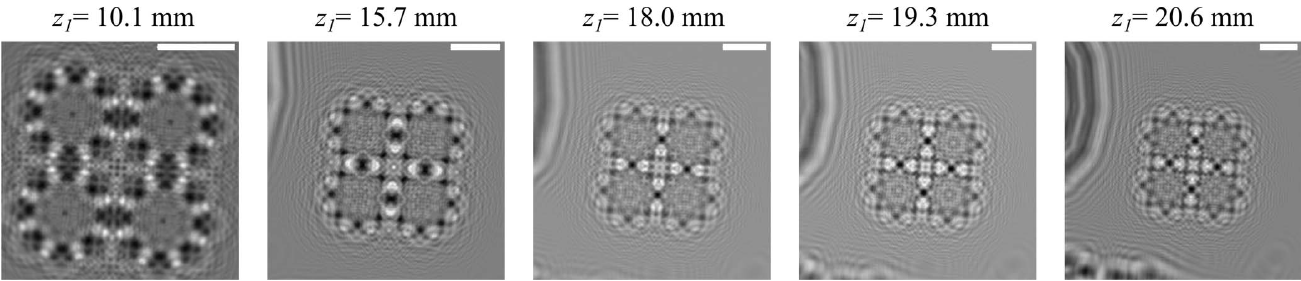
Figure 4 Recorded holograms at different defocusing distances ( z 1 ) of the 2D test pattern. The white scale bar corresponds to 4 m m for all the